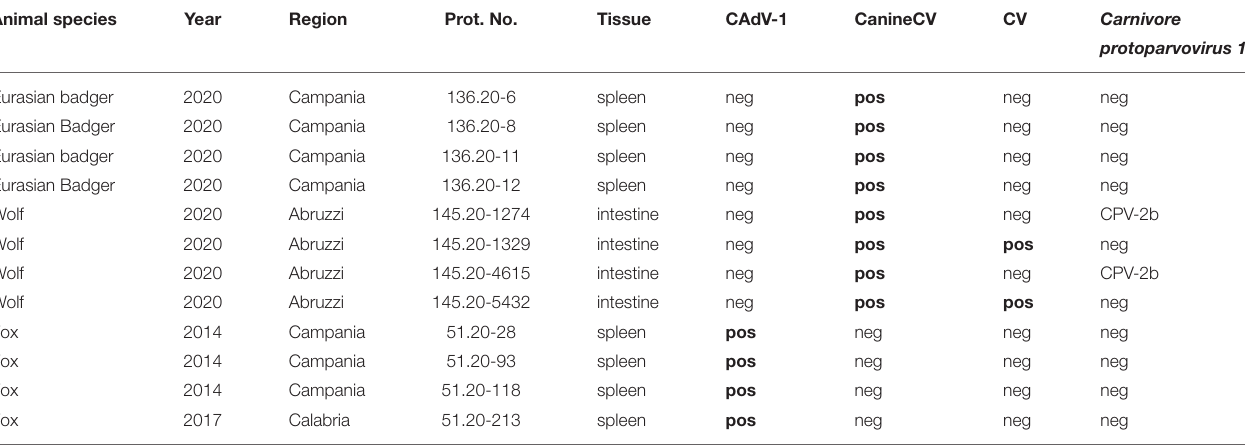
TABLE 1 | Sample distribution according to Italian regions, year of collection and wild carnivore species. Animal